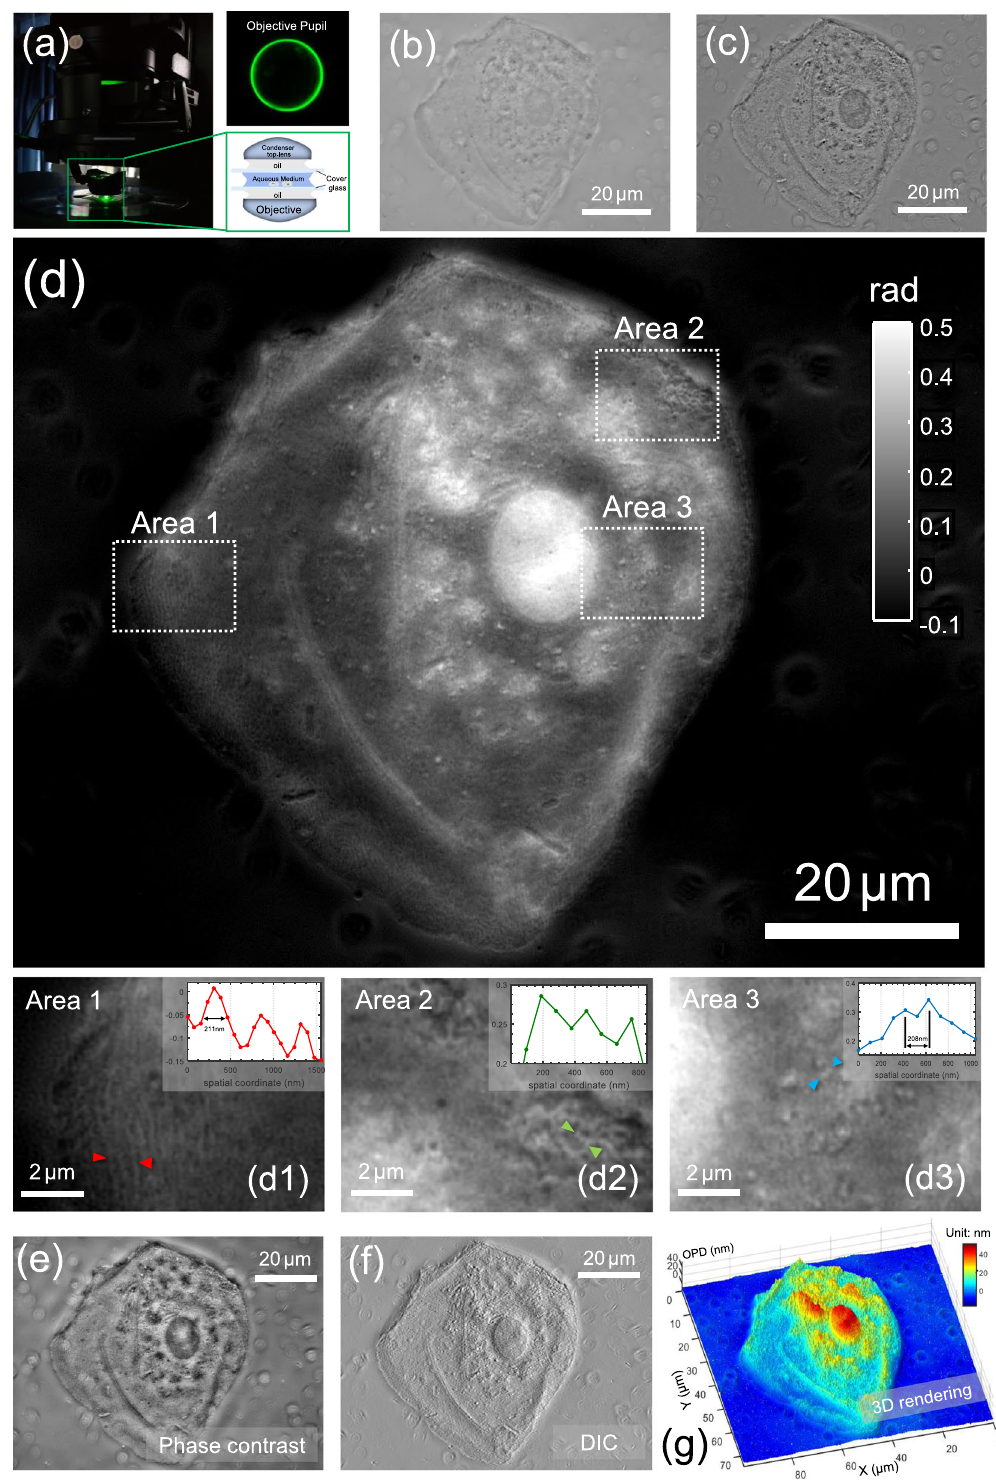
Figure 12. High-resolution imaging of buccal epithelial cell. ( a ) Optical configuration with the corresponding rear focal plane image of the objective. ( b ) In-focus intensity image. ( c ) Intensity difference image. ( d ) Reconstructed phase image. Three areas of interest (boxed regions) are enlarged in (d1–d3). The insets shows line profiles taken at different positions in the cell. ( e ) Simulated phase-contrast image; ( f ) Simulated DIC image; ( g ) Pseudo-color 3D rendering of the cell optical